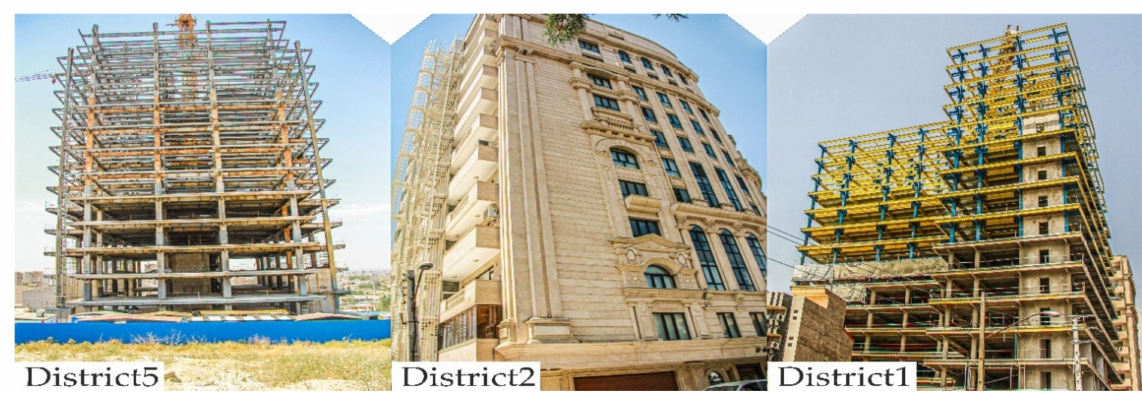
Figure 11. Steel-1 structures up to 3 floors.